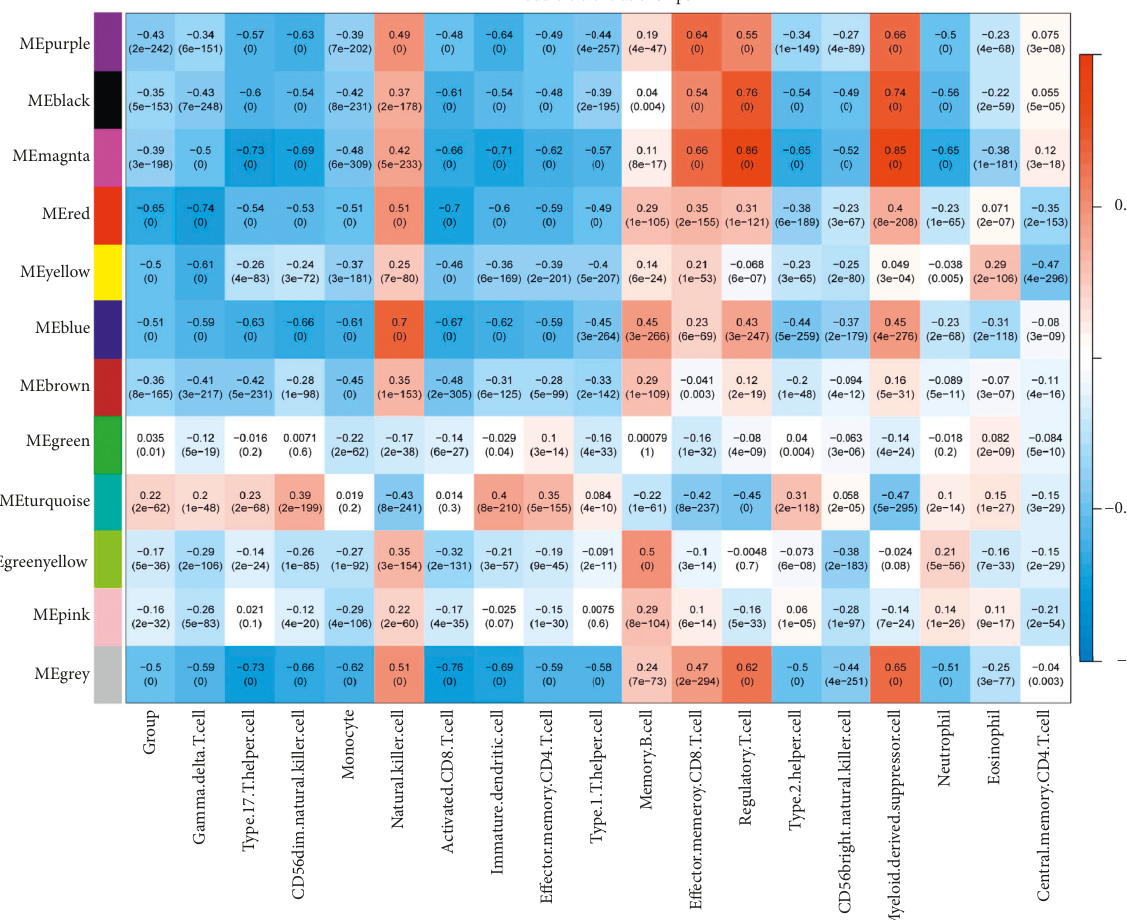
Figure 5: Finally, calculate the correlation between the 18 important immune information screened in the second step and each module divided, as shown in Figure